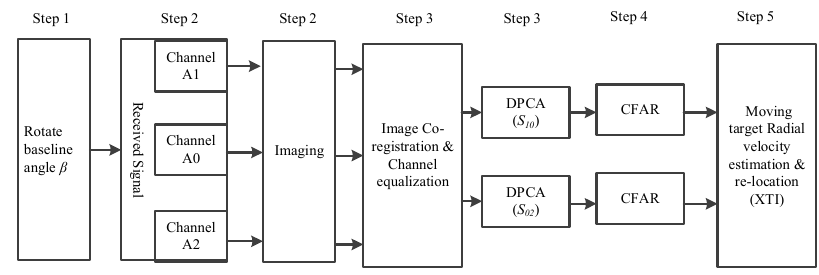
Figure 5. The signal processing flowchart of a three-channel Ro-XTI-SAR system.